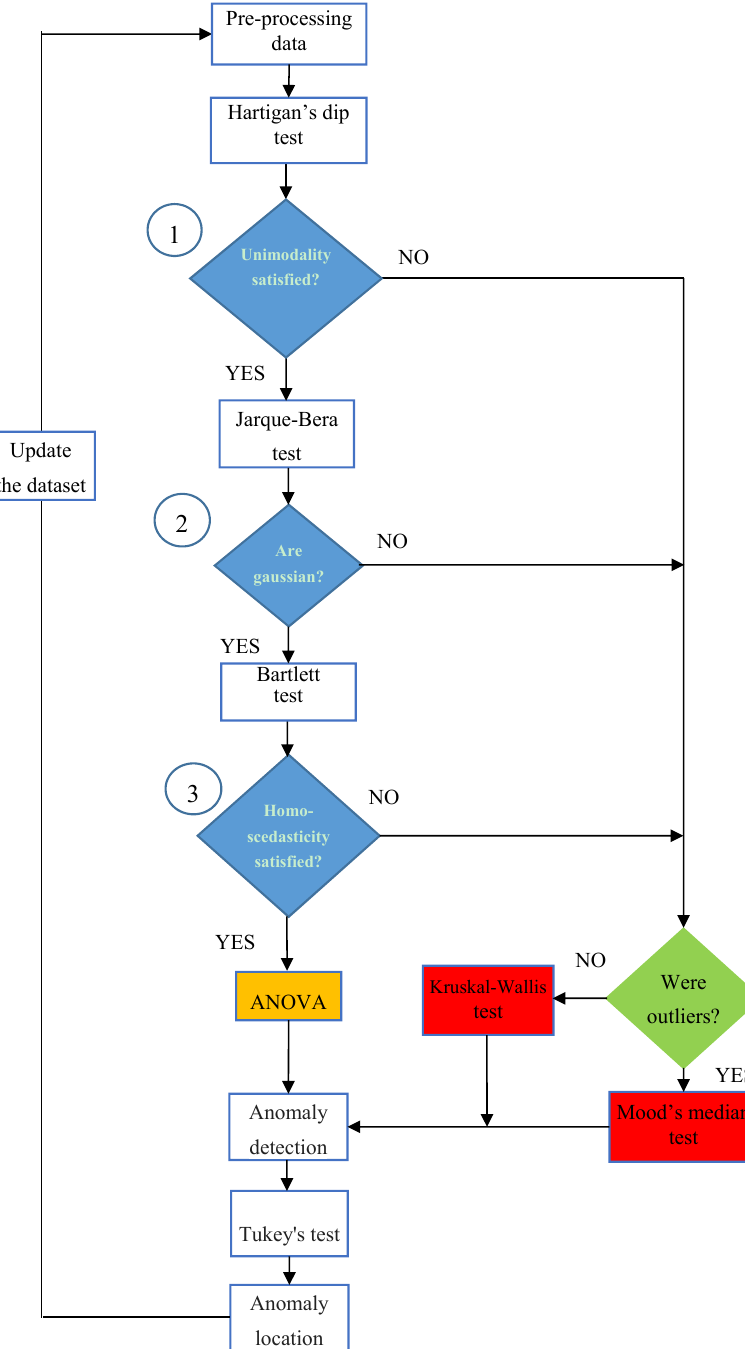
Figure 2. Statistical methodology.